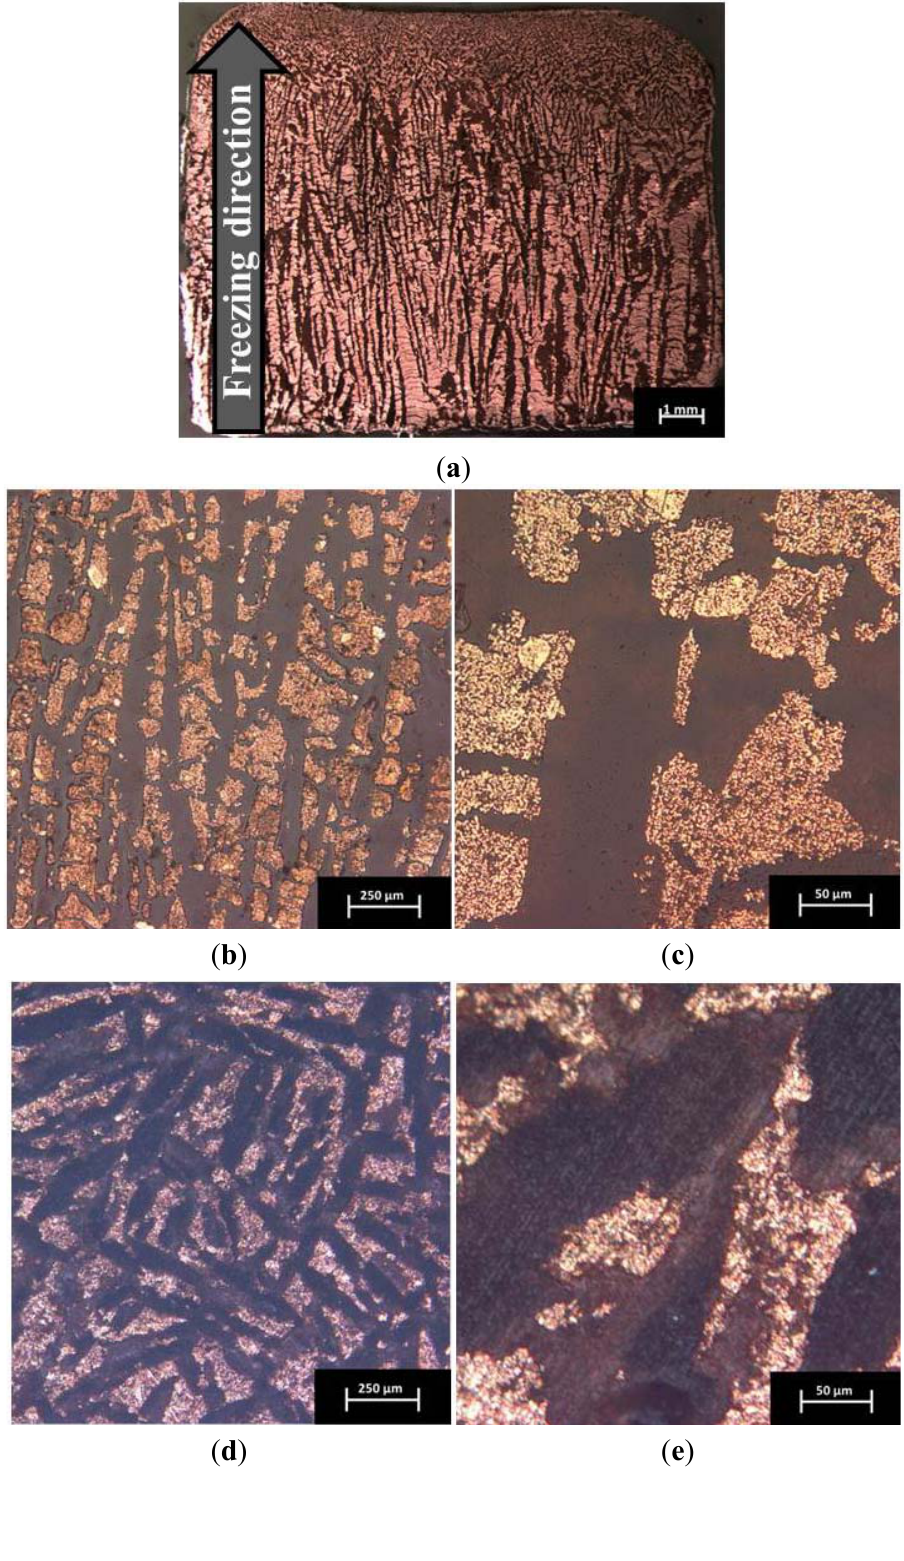
Figure 2. Optical micrographs of sample 2 obtained from a 15 vol % CuO suspension. Longitudinal cross-sections, at ( a ) low, ( b ) medium and ( c ) high magnification. Transverse cross-sections at ( d ) medium and ( e ) high